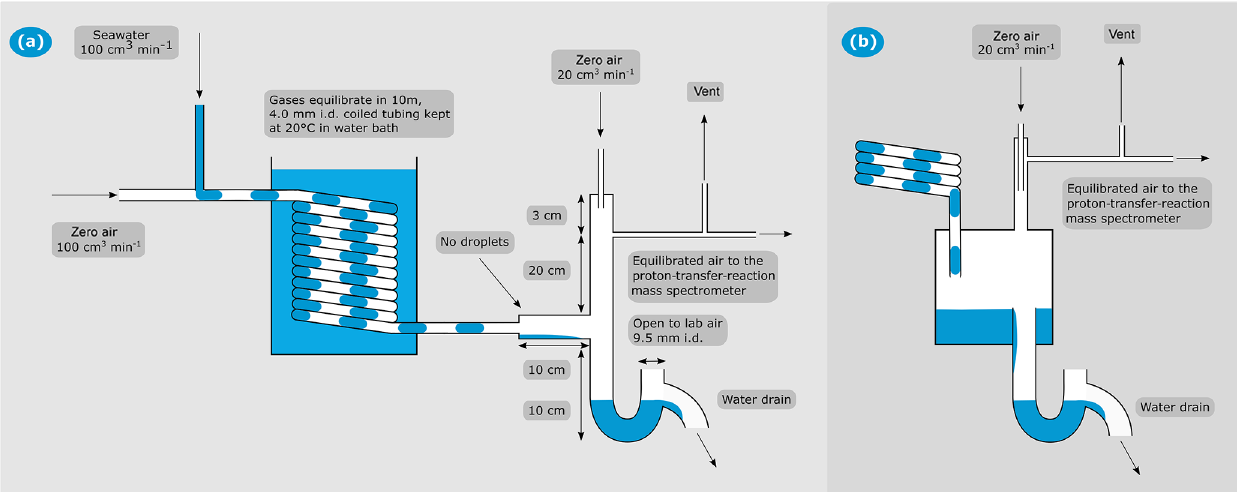
Figure 1. (a) Schematic of the segmented flow coil equilibrator coupled to PTR-MS. (b) Schematic of the jar that was used during the field testing presented here for air–water separation. All other aspects of the SFCE were the same for the two